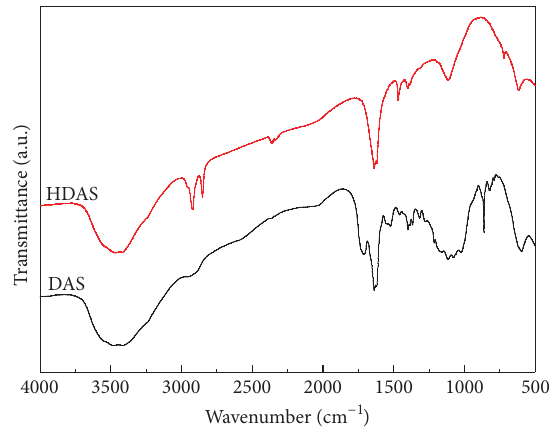
Figure 2: FTIR analysis of DAS and